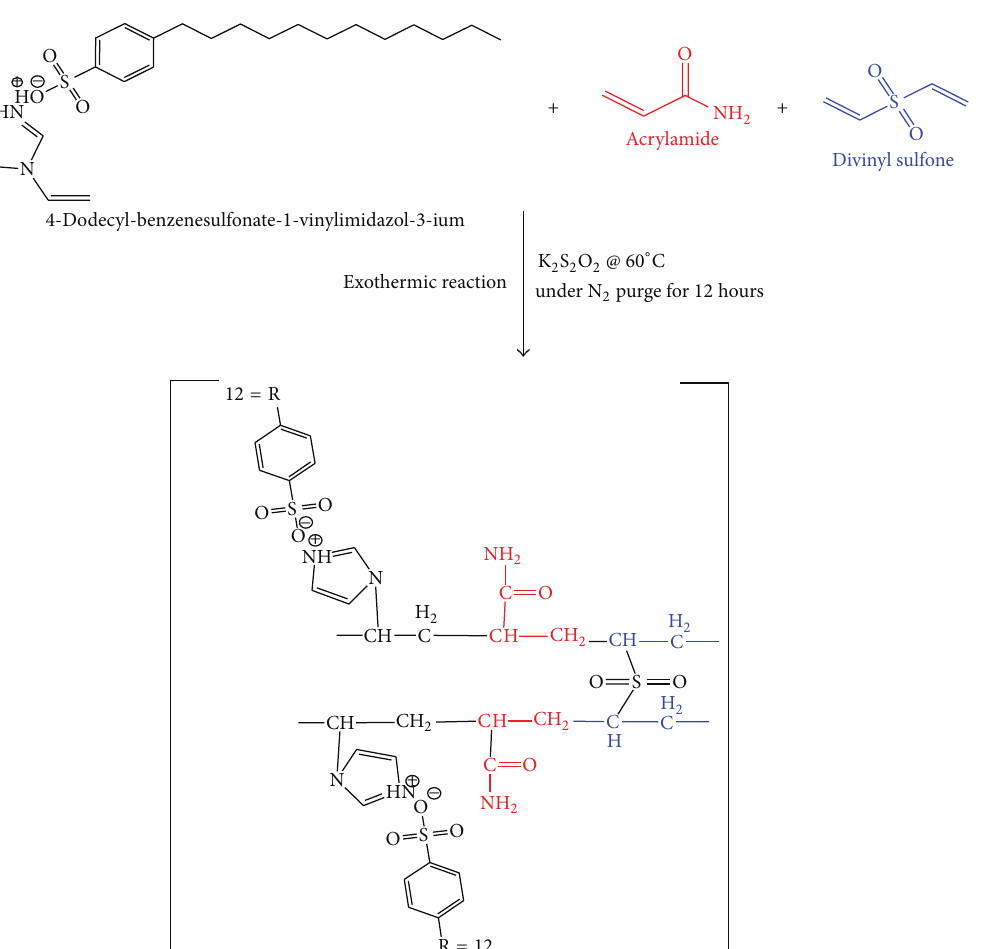
Figure 1: Chemical structure of HAPAM